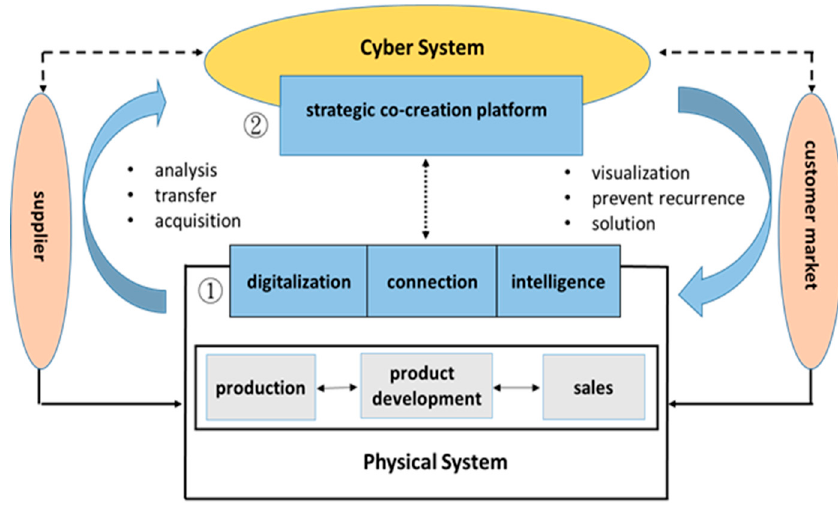
Figure 1. Lean smart manufacturing architecture and solution platform. Source: Li et al.